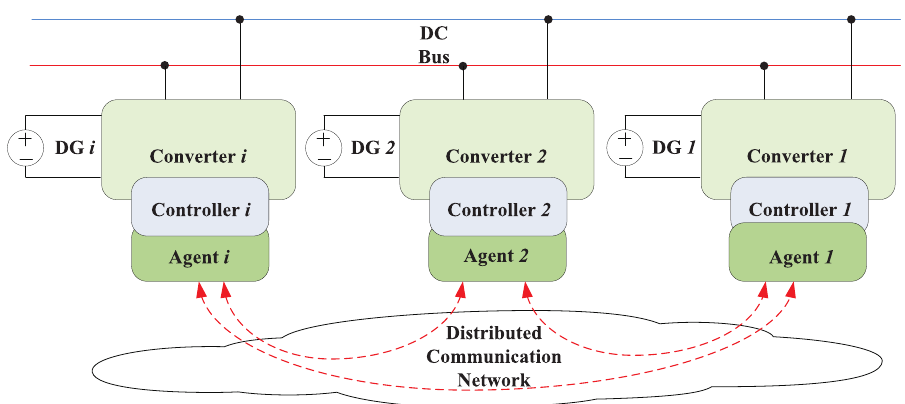
Figure 2. Agent-based distributed control architecture for a DC